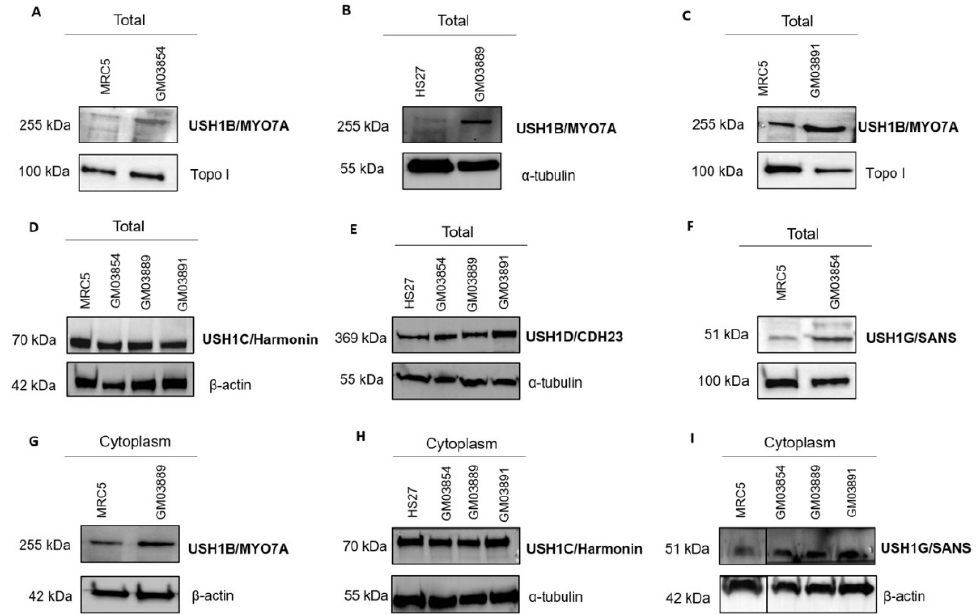
Figure 7. Representative immunoblots of USH1 protein expression in USH1 fibroblasts: A total of 30 µg of protein was subjected to SDS/PAGE. Representative immunoblots showing the expression of different USH1 proteins in the indicated radioresistant control and USH1 fibroblasts. Expression of USH1B ( A – C ), USH1C ( D ), USH1D ( E ), and USH1G ( F ) in total protein extracts. Expression of USH1B ( G ), USH1C ( H ), and USH1G/SANS ( I ) in cytoplasmic protein extracts. It is noteworthy that the blot was cut to provide panel I.